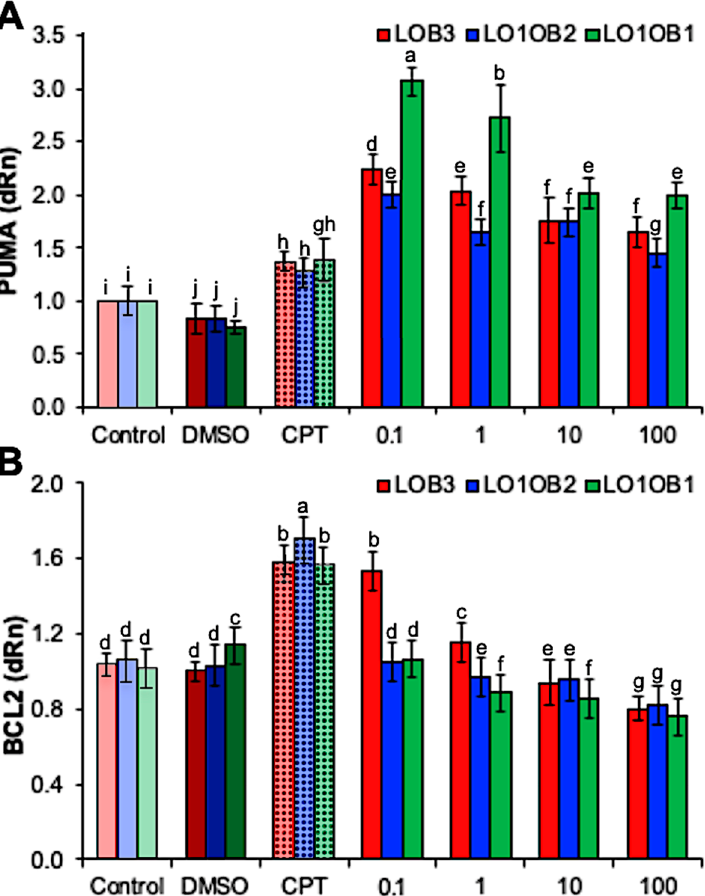
Figure 4. Gene expressions of ( A ) PUMA and ( B ) BCL2 after LO treatments. DMSO is a common negative control and is used as a solvent for dissolving LOs as LOs do not dissolve in water. CPT (positive control) is a cytotoxic quinoline alkaloid that inhibits the DNA enzyme topoisomerase I and has shown remarkable anti-cancer activity. The different letters (a–j) represent significance at p < 0.05.